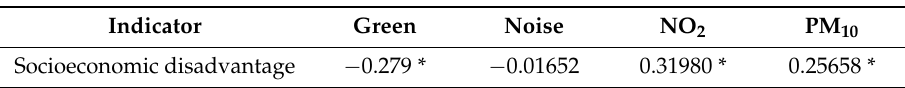
Table 6. Spearman rank correlation coefficients between neighborhood socioeconomic disadvantage and environmental indicators.